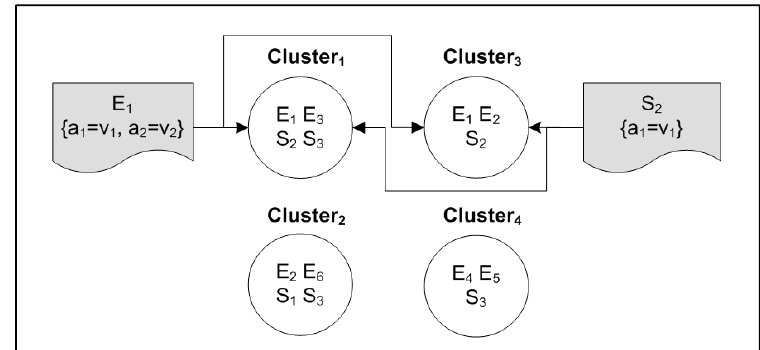
Figure 2. Clustering events and subscriptions. Algorithm 1 Building the Cluster Index List for Events.